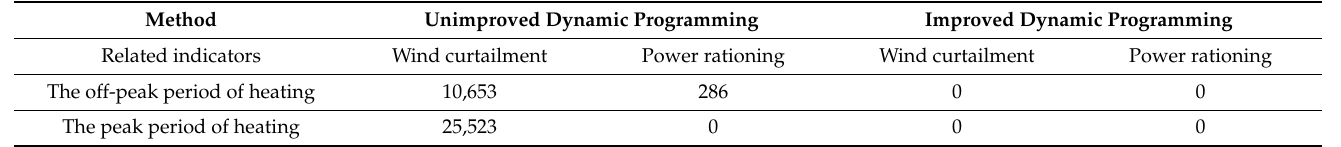
Table 3. Related indicators for unimproved and improved dynamic